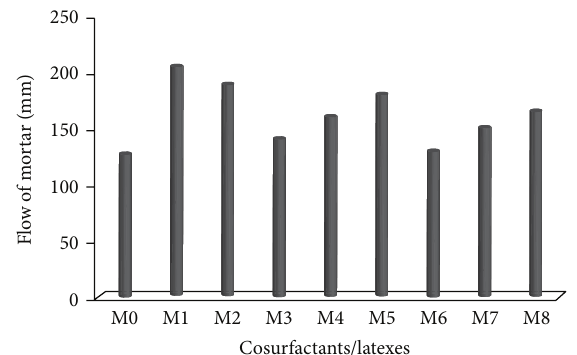
Figure 1: The effect of cosurfactants and copolymer latexes on the flow of